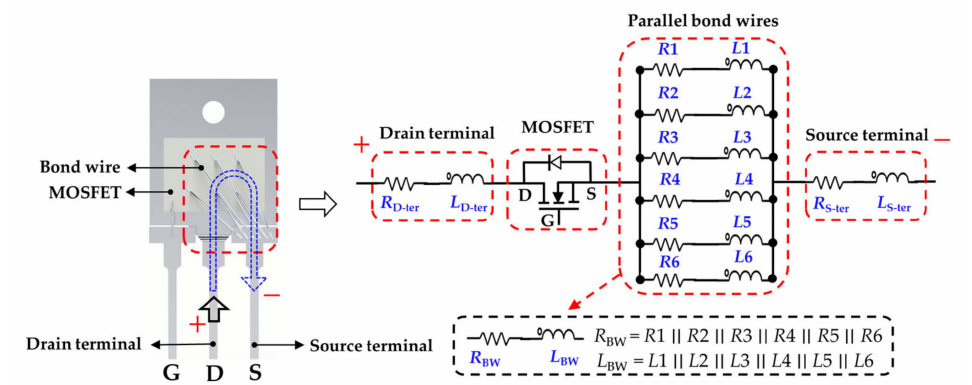
Figure 2. Simplified RL equivalent of a MOSFET in TO − 247